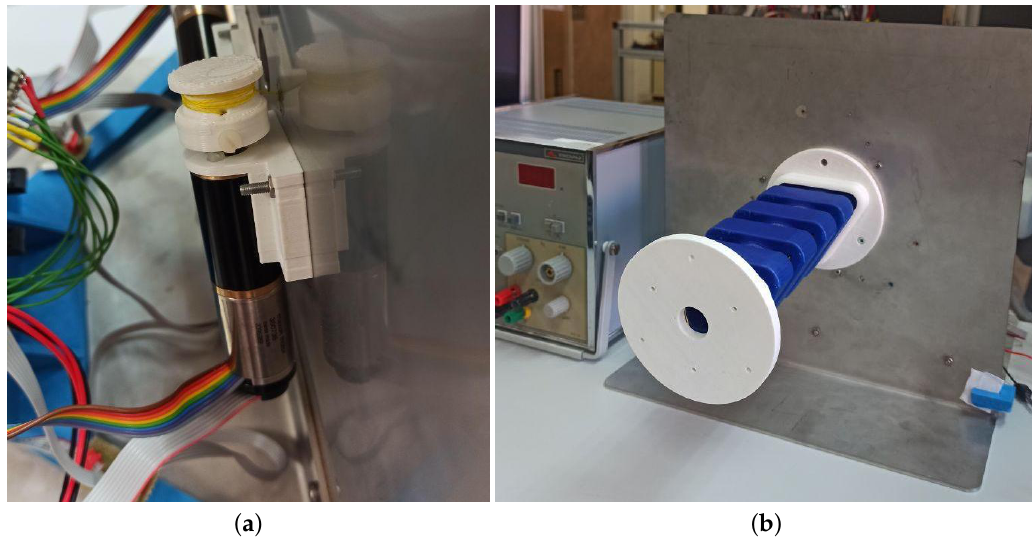
Figure 6. ( a ) Motor connected to the winch to wind the tendons for joint actuation. ( b ) Soft joint on the test platform.